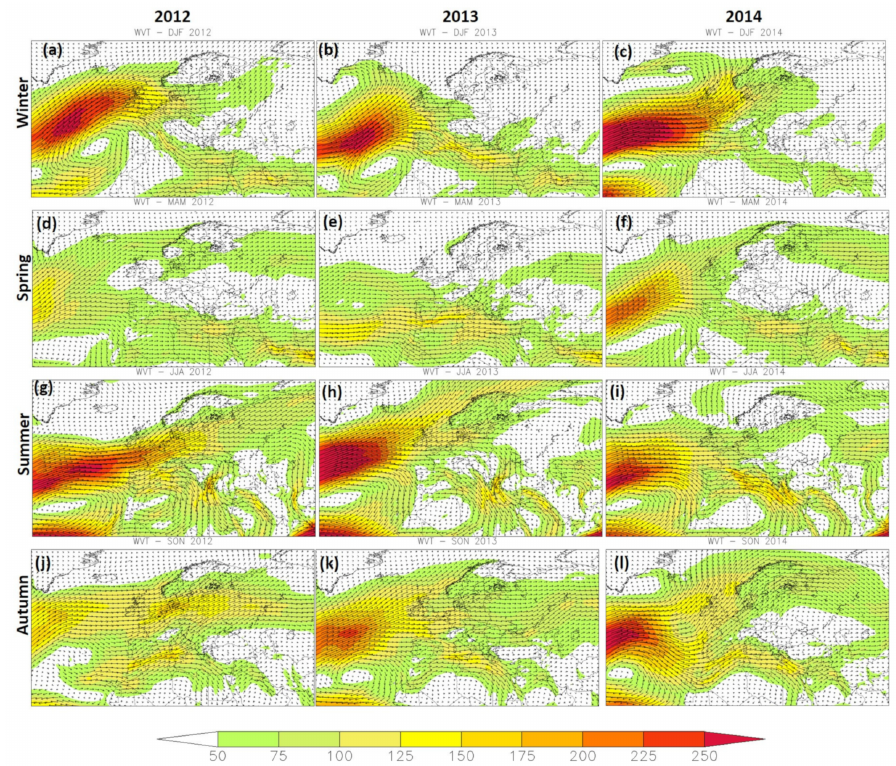
Figure 9. Magnitude (shaded colors) and direction (vectors) of the seasonal integrated water vapor transport (WVT) for the period January 2012 to December 2014. Units: WVT (kg * s − 1 * m − 1